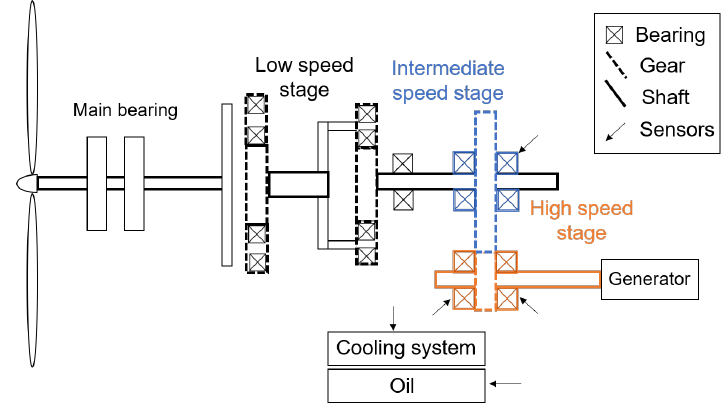
Figure 1. General multi-MW gearbox configuration.